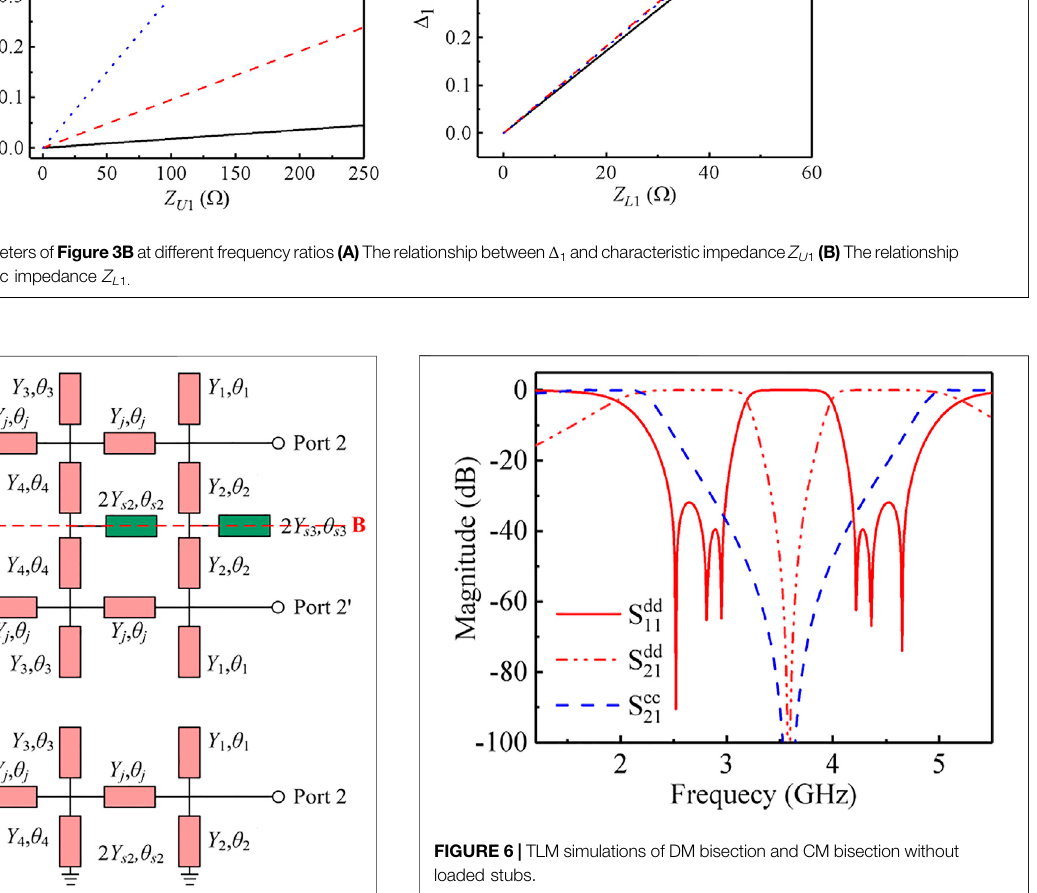
FIGURE 5 | (A) TLM of the proposed third-order dual-wideband balanced BPF (B) Its DM equivalent circuit.